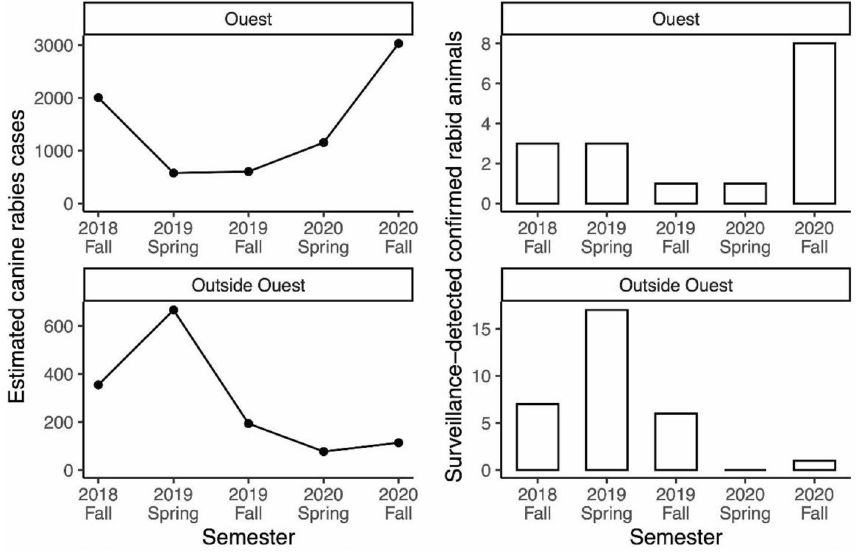
Figure 1. Dog rabies cases in Haiti since July 2018, as total number of cases estimated by the model* † (left) and number of surveillance investigations resulting in confirmed positive cases (right). *Results are presented separately for Ouest Department (top), where the last vaccination campaign took place in 2018, and outside Ouest Department (bottom), where the last vaccination campaign took place in 2019. † These plots show estimated total dog rabies cases. Supplementary Appendix Table S4 compares model estimates of dog rabies cases and with confirmed rabid animals detected through surveillance data. Note that typically only animals with reported human bites are